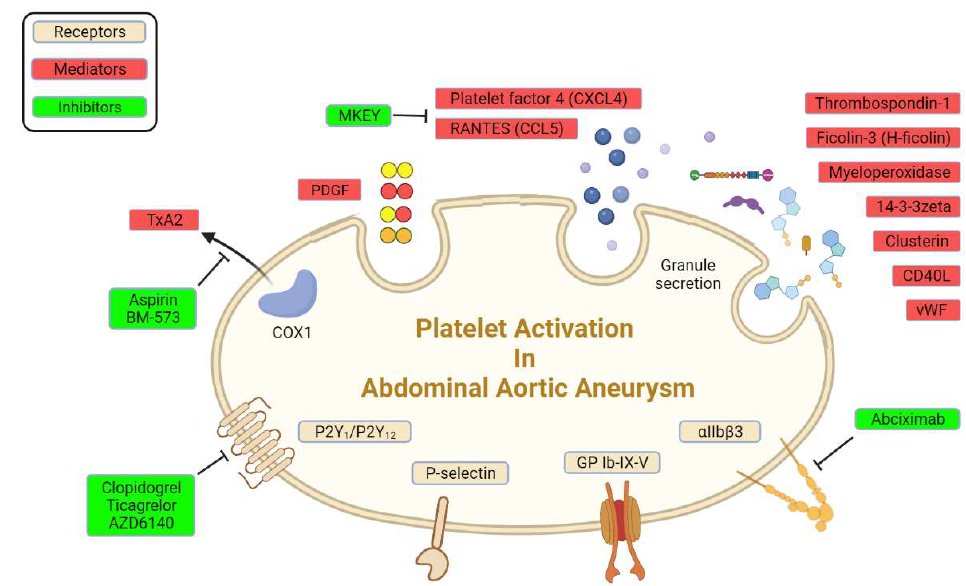
Figure 1. Platelet receptors and derived mediators in AAA.